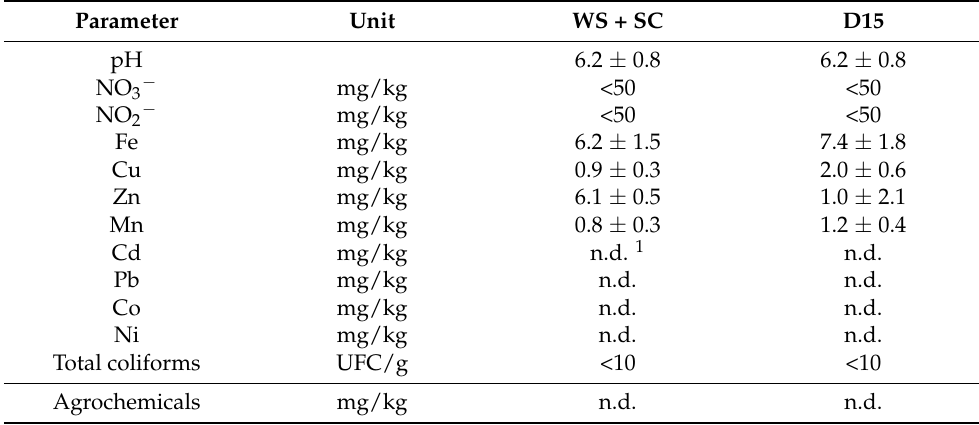
Table 3. Chemical parameters of the fruiting bodies of P. ostreatus harvested from the conventional substrate (WS+SC) and the experimental one (D15).